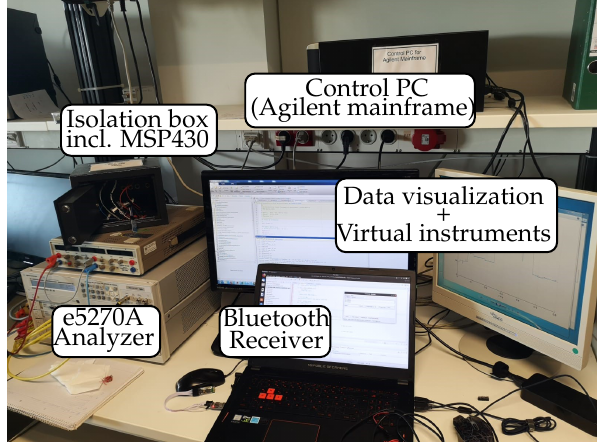
Figure 11. Experimental setup for Bluetooth